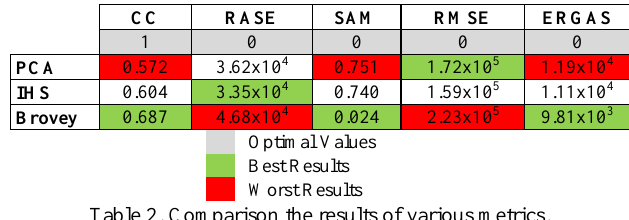
Table 2. Comparison the results of various